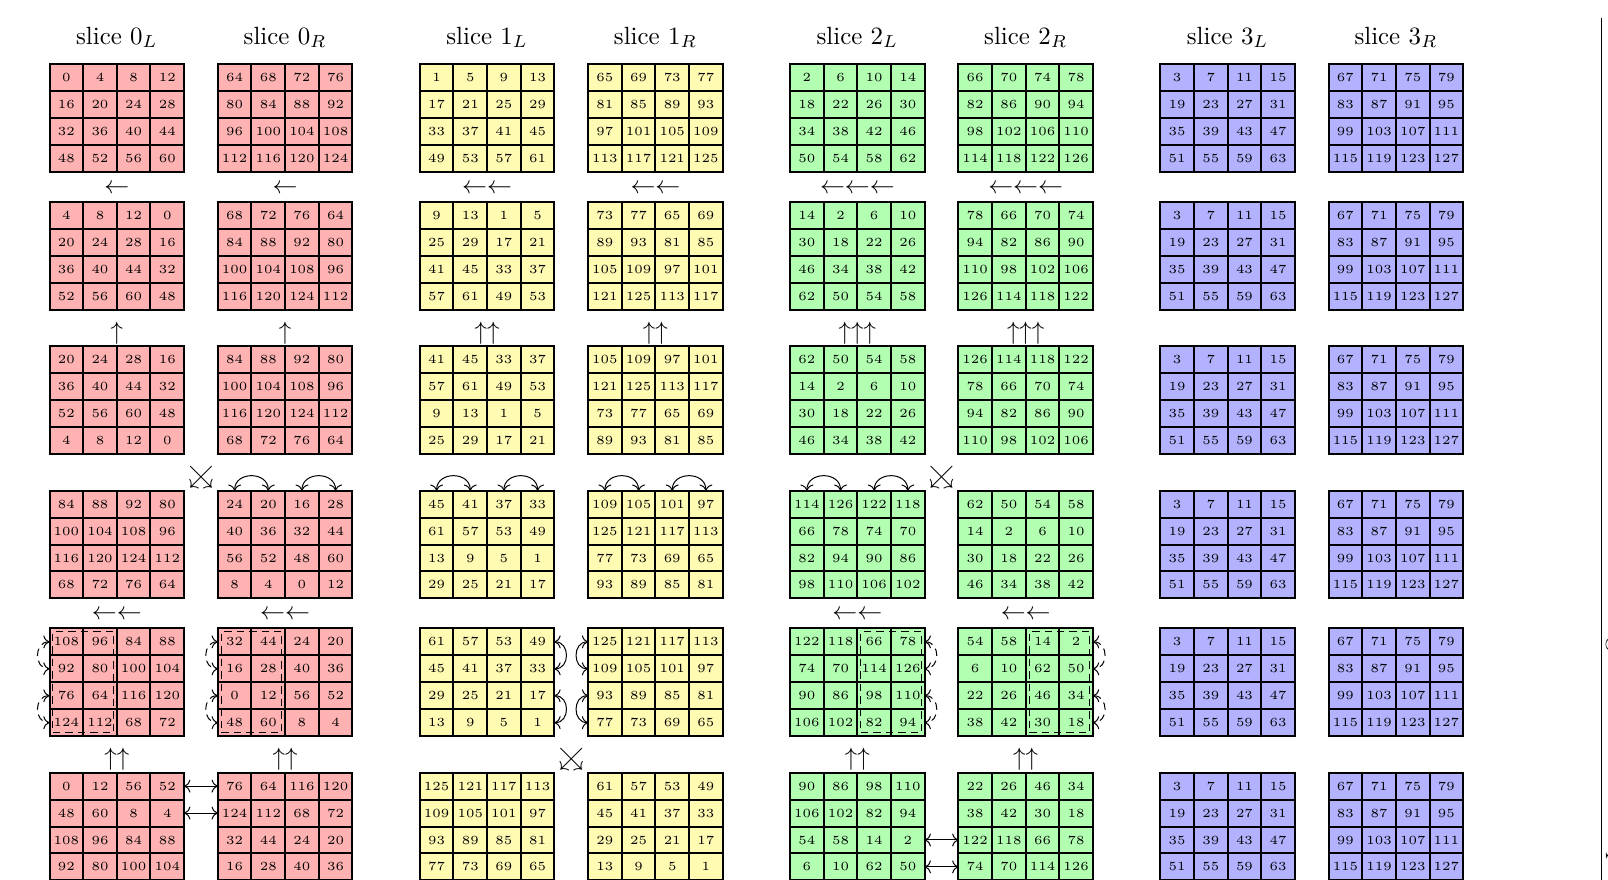
Figure 7: New representation of the GIFT-128 round function during 5 rounds. Each cell represents a bit, and the numbers in the cells then denote the actual index of that particular bit in the state. Slice 0 (resp. 1/2/3) depicted in red (resp. yellow/green/blue) represents all the bits at position 0 (resp. 1/2/3) of the S-boxes of the cipher